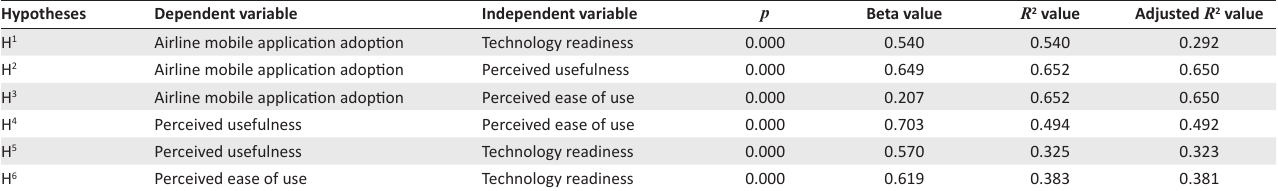
TABLE 4: Regression analysis summary for the hypotheses set out for the study. Hypotheses